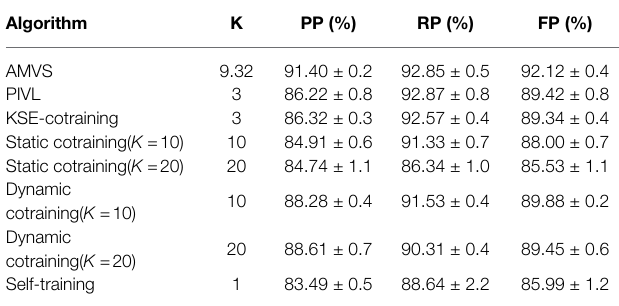
TABLE 3 | Comparison results of recognition algorithms when the label-free rate is taken as 0.5 (base classifier is MNB).